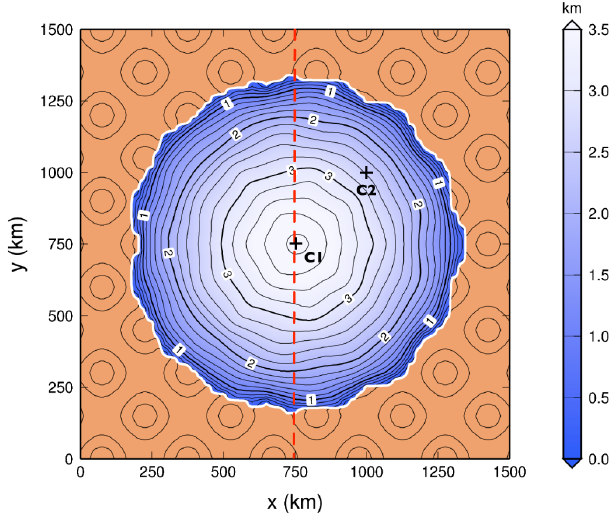
Figure 6. Steady-state surface elevation of the EISMINT experi- ment K at simulation time 300kyr. The two crosses mark the core locations C1 and C2, and the dashed red line indicates the cross sec- tion. This cross section cuts through the ice centre dome where core C1 is